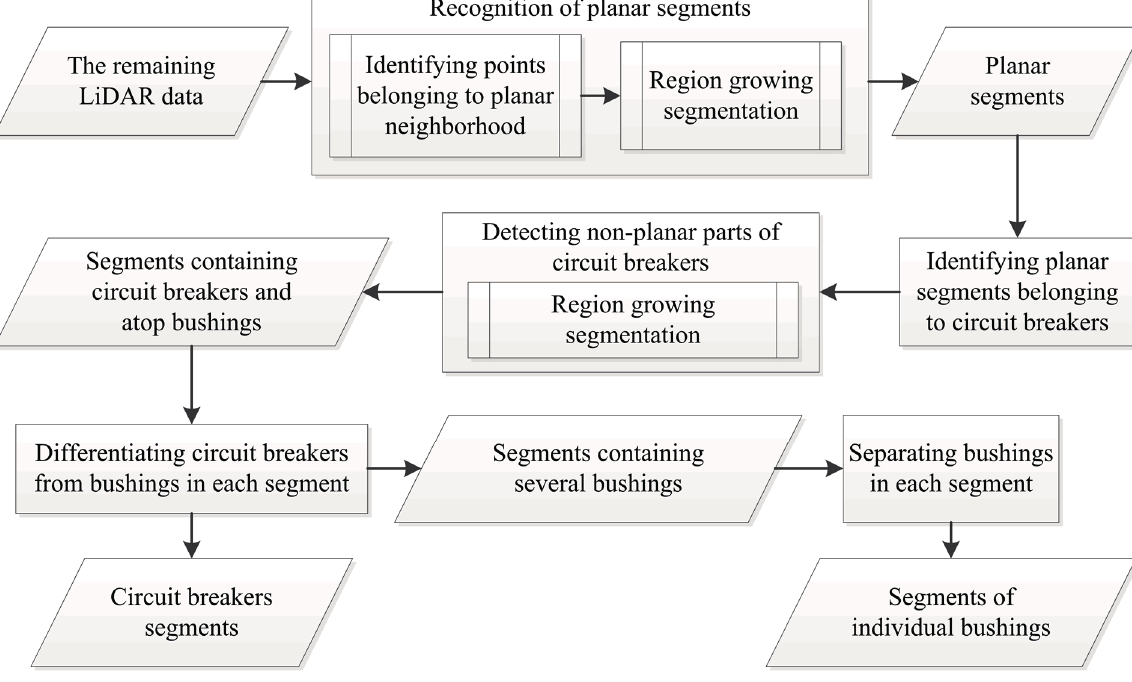
Figure 9. Flowchart of circuit breaker and bushing recognition.